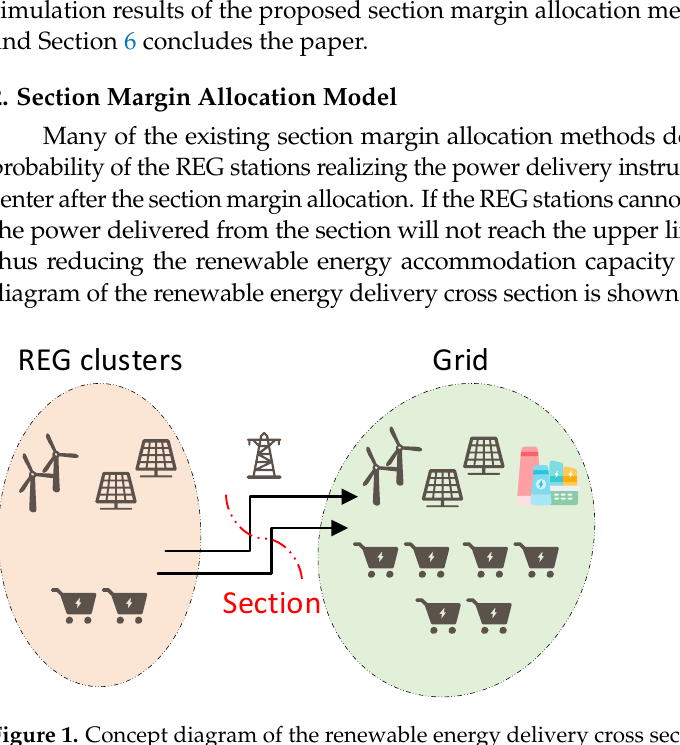
Figure 1. Concept diagram of the renewable energy delivery cross section.